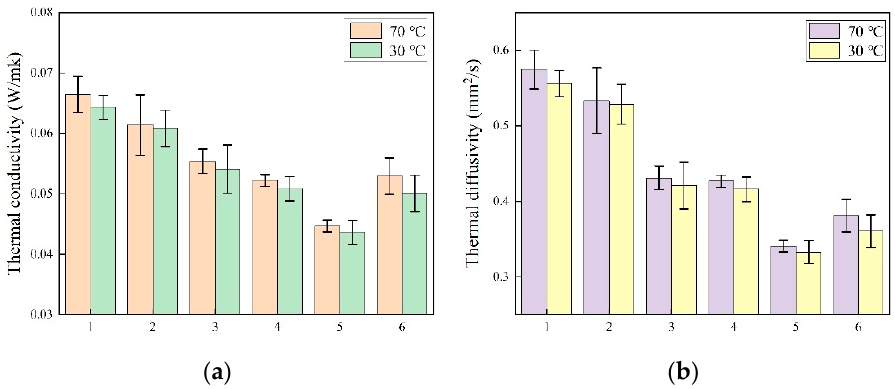
Figure 8. ( a ) Thermal conductivity of PVA–GA aerogels and PVA–GA–CNF ‐ (1–5) aerogels. ( b ) Thermal diffusivity of PVA–GA aerogels and PVA–GA–CNF ‐ (1–5) aerogels . The thermal conductivity and thermal diffusion coefficient of the PVA–GA aerogel and PVA–GA–CNF ternary composite aerogel at 30 °C and 70 °C were tested. Figure 8 can be attributed to the solid–liquid phase transition, which is consistent with previous